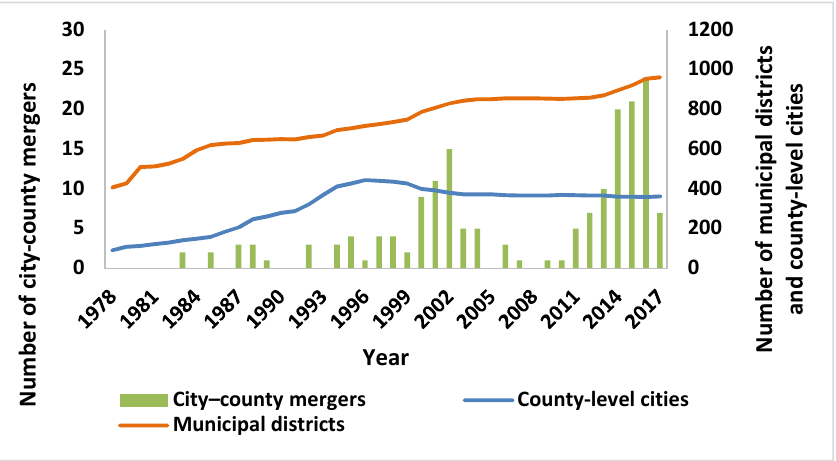
Figure 1. Number of municipal districts, county-level cities and city-county mergers since